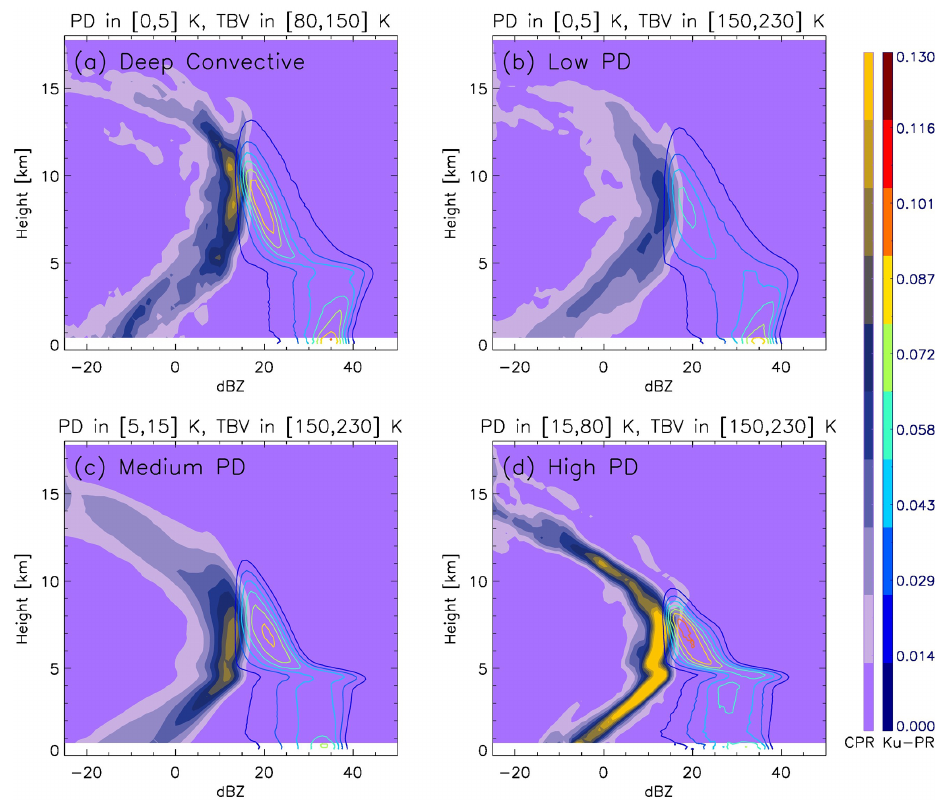
Figure 2. The 2D PDFs from CloudSat (color shaded) and DPR Ku (color contours) for the four regimes in Fig. 1 integrated from all tropical (30 ◦ S–30 ◦ N) collocated scenes. Panels (a) – (d) correspond to regimes 1–4, respectively. The contour scale is linear and relative to its maximum value.